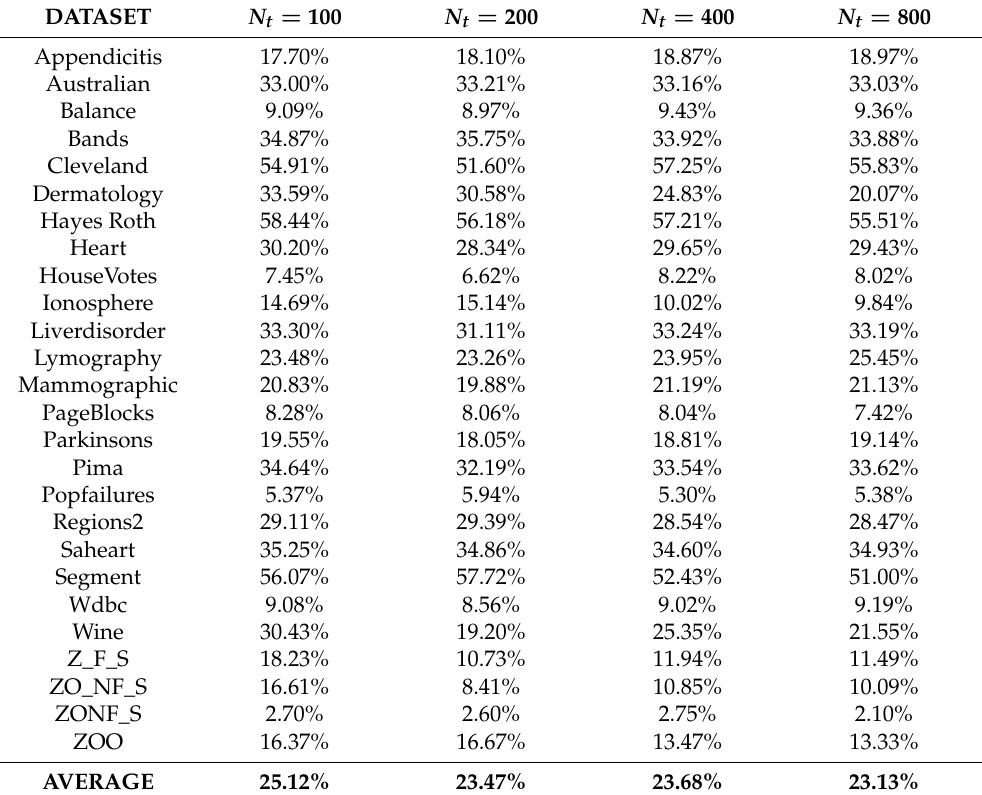
Table 6. Experiments with the genetic method and various values of N t for the classification datasets.